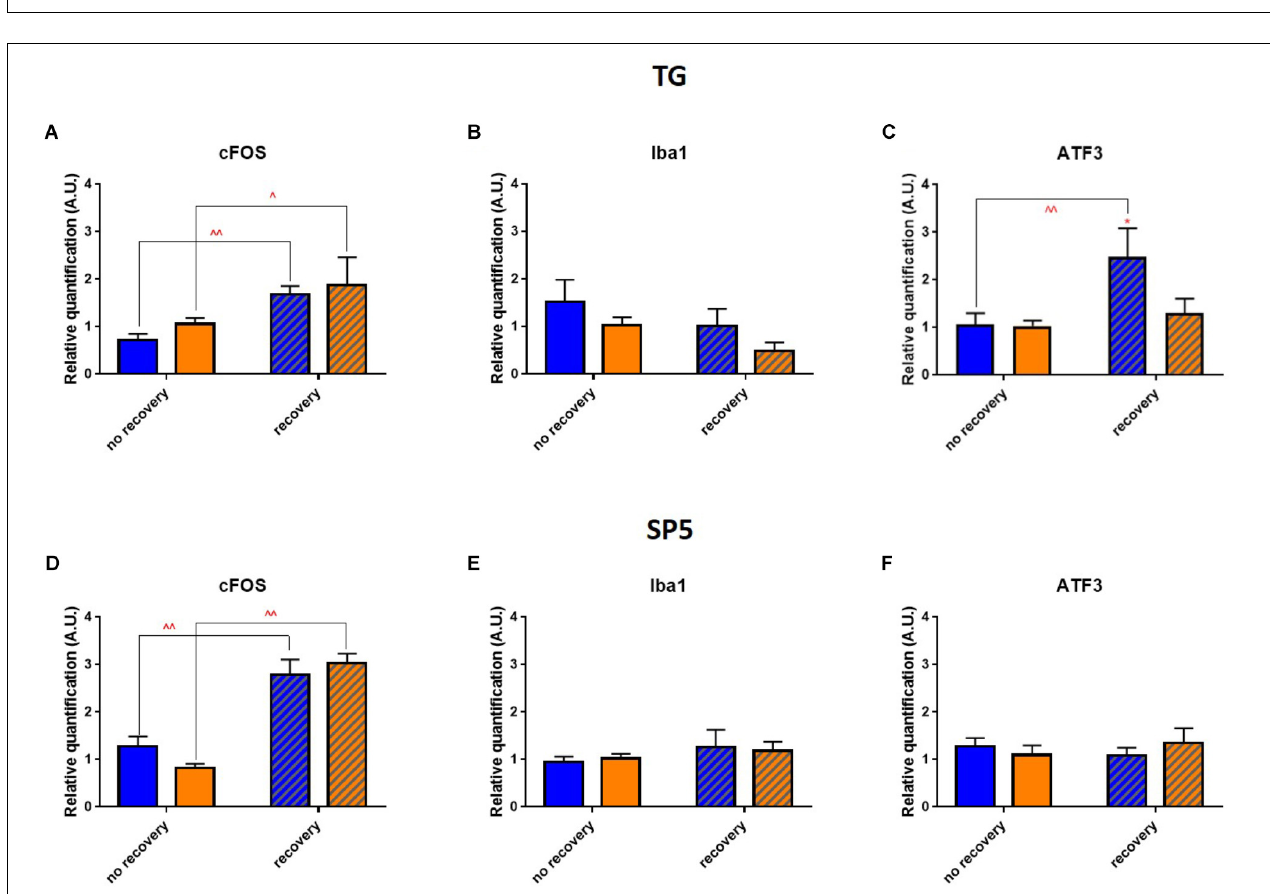
FIGURE 10 | Phototoxicity marks in the trigeminal pathway. (A–C) Results of RT-qPCR analysis on the TGs: mRNA expression of cFOS (A) , Iba1 (B) , and ATF3 (C) . Statistical significance: cFOS: blue no recovery vs. recovery – q = 0.0129, p = 0.0061; yellow no recovery vs. recovery – q = 0.0339, p = 0.0323; ATF3: blue no recovery vs. recovery – q = 0.0076, p = 0.0072; recovery blue vs. yellow – q = 0.0243, p = 0.0231. (D–F) Results of RT-qPCR analysis on the brainstems: mRNA expression of cFOS ( D ; blue no recovery vs. recovery – q < 0.0001, p < 0.0001; yellow no recovery vs. recovery – q < 0.0001, p < 0.0001), Iba1 (E) and ATF3 (F) . Blue and yellow bars correspond to blue and yellow exposures, respectively; clear and hatched bars correspond to the time points of mice dissection, either directly after illumination ( no recovery ) or in 3 days of recovery ( recovery ), respectively. All the data are presented as mean ± SEM. Differences were considered significant when p < 0.05 ( ∗ / ∧ ), p < 0.01 ( ∗∗ / ∧∧ ), p < 0.001 ( ∗∗∗ / ∧∧∧ ) or p < 0.0001 ( ∗∗∗∗ / ∧∧∧∧ ). Stars correspond to comparisons between blue-illuminated and yellow-illuminated mice, treated with the same drug. Carets correspond to comparison of mice assessed directly after illumination to the ones after 3 days of recovery, within the same spectra. Red color means increase and blue color decrease in